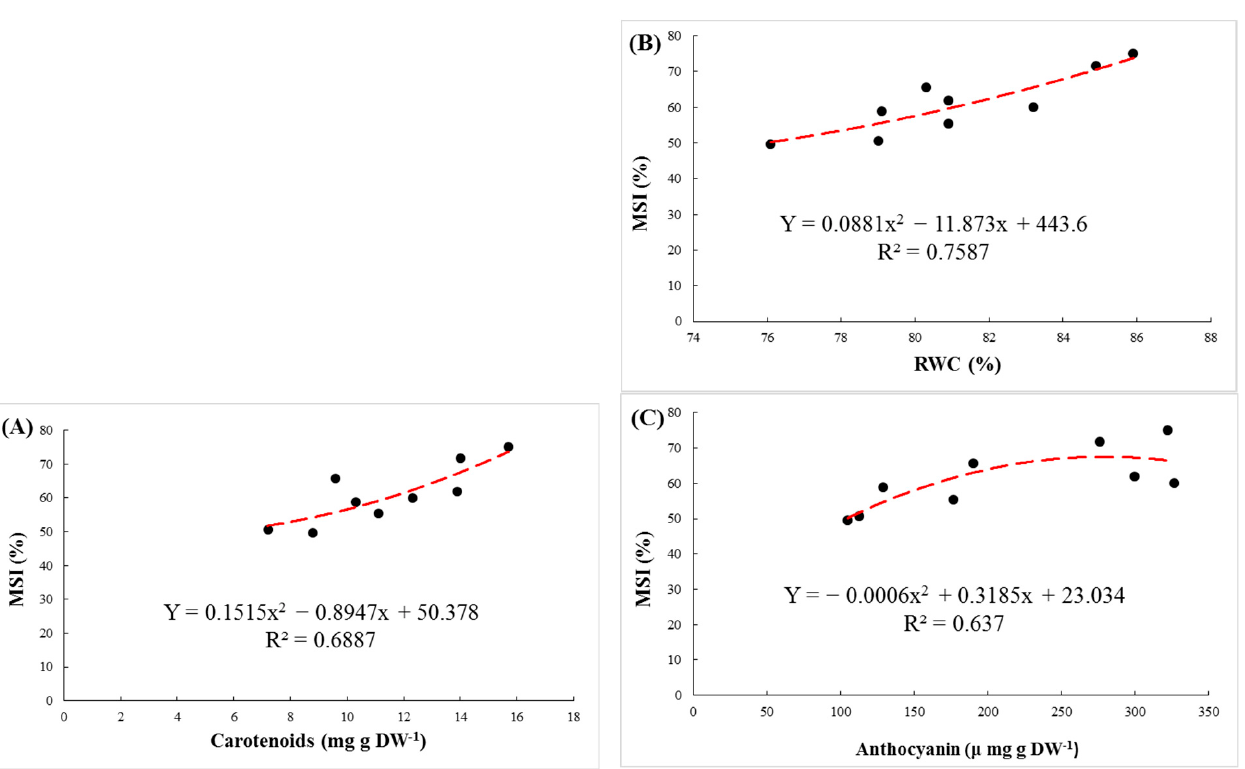
Figure 3. The regression between membrane stability index (MSI) and carotenoids ( A ), relative water content (RWC) ( B ) and anthocyanin ( C ) in leaves of pistachio rootstocks under salinity stress.